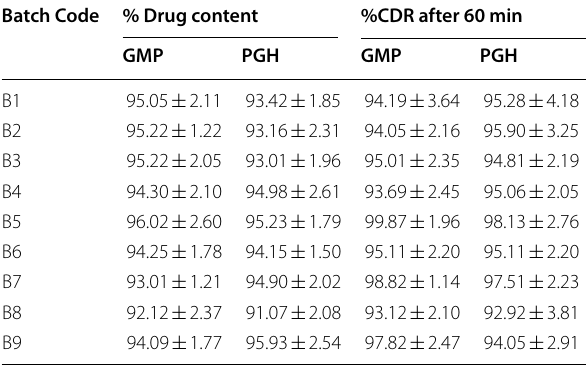
Values are mean